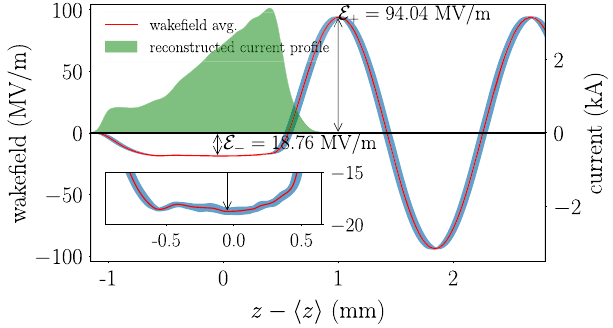
FIG. 19. Wakefields obtained from 100 simulations with fac- tional magnetic field jitter Δ B=B ¼ 10 − 4 on all the magnets. The red line shows the average wakefield while the blue shaded region represents the fluctuation of wakefields due to jitter over 100 random realizations. The reconstructed current profile (green- shaded curve) is obtained numerically using Eq. (4).